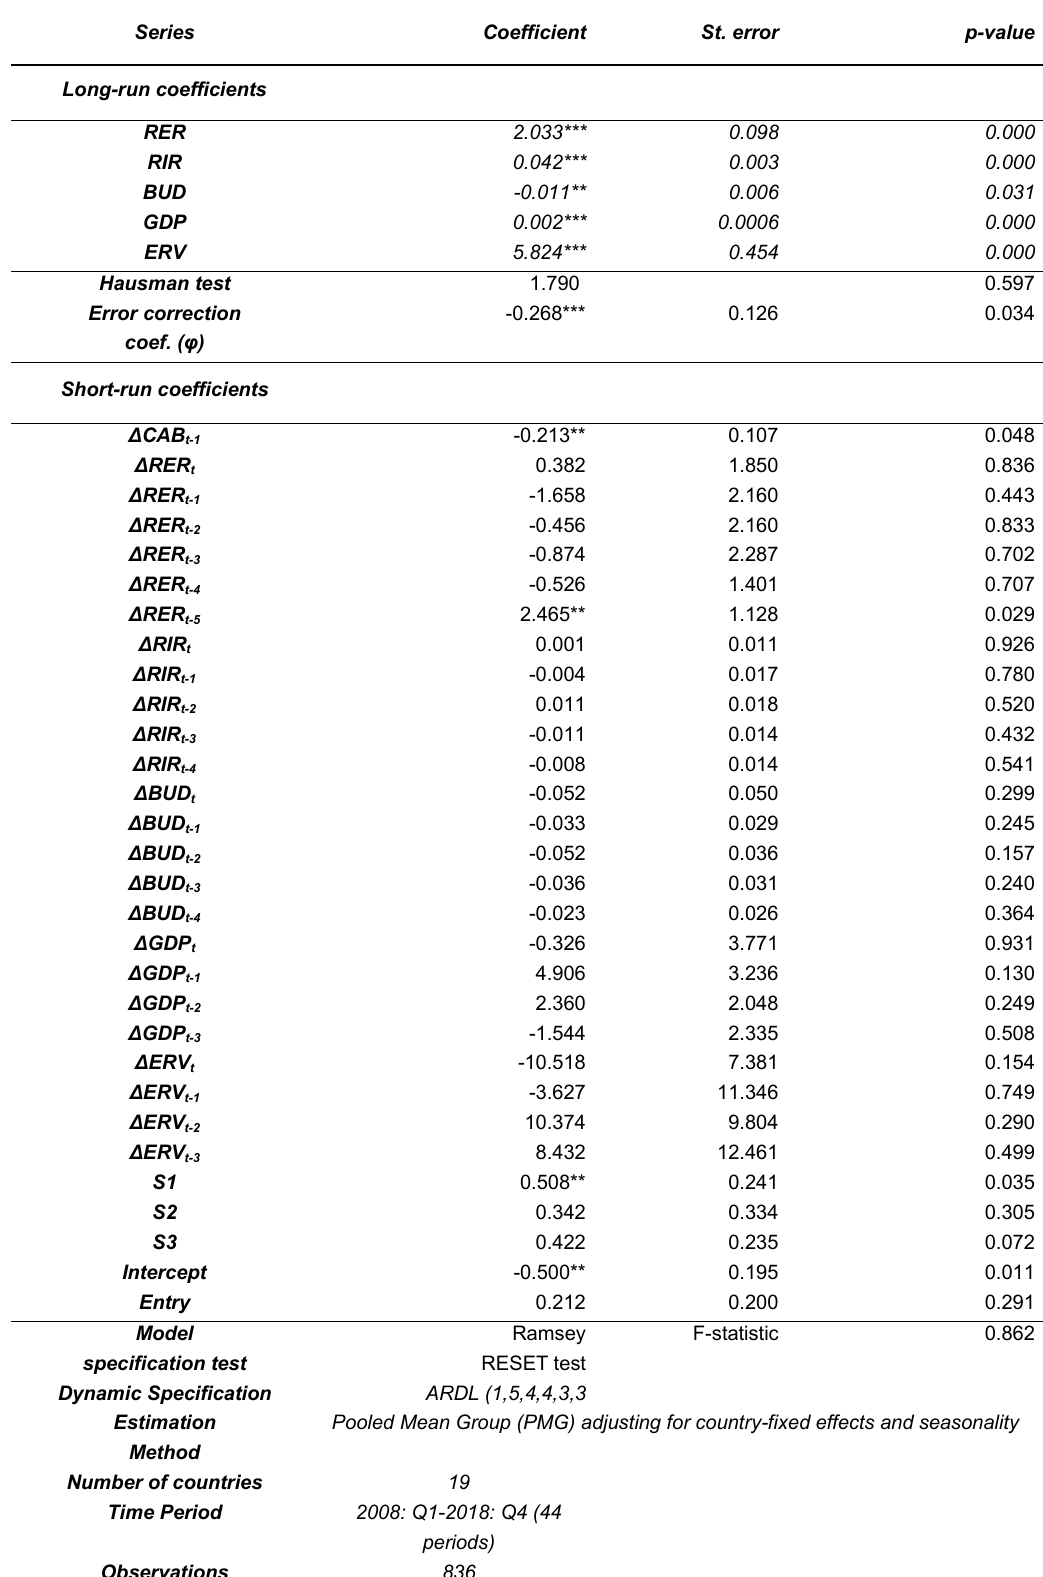
Table 7. Long-run and Short-run coefficients of the Current Account Balance determinants, ARDL (1,5,4,4,3,3).